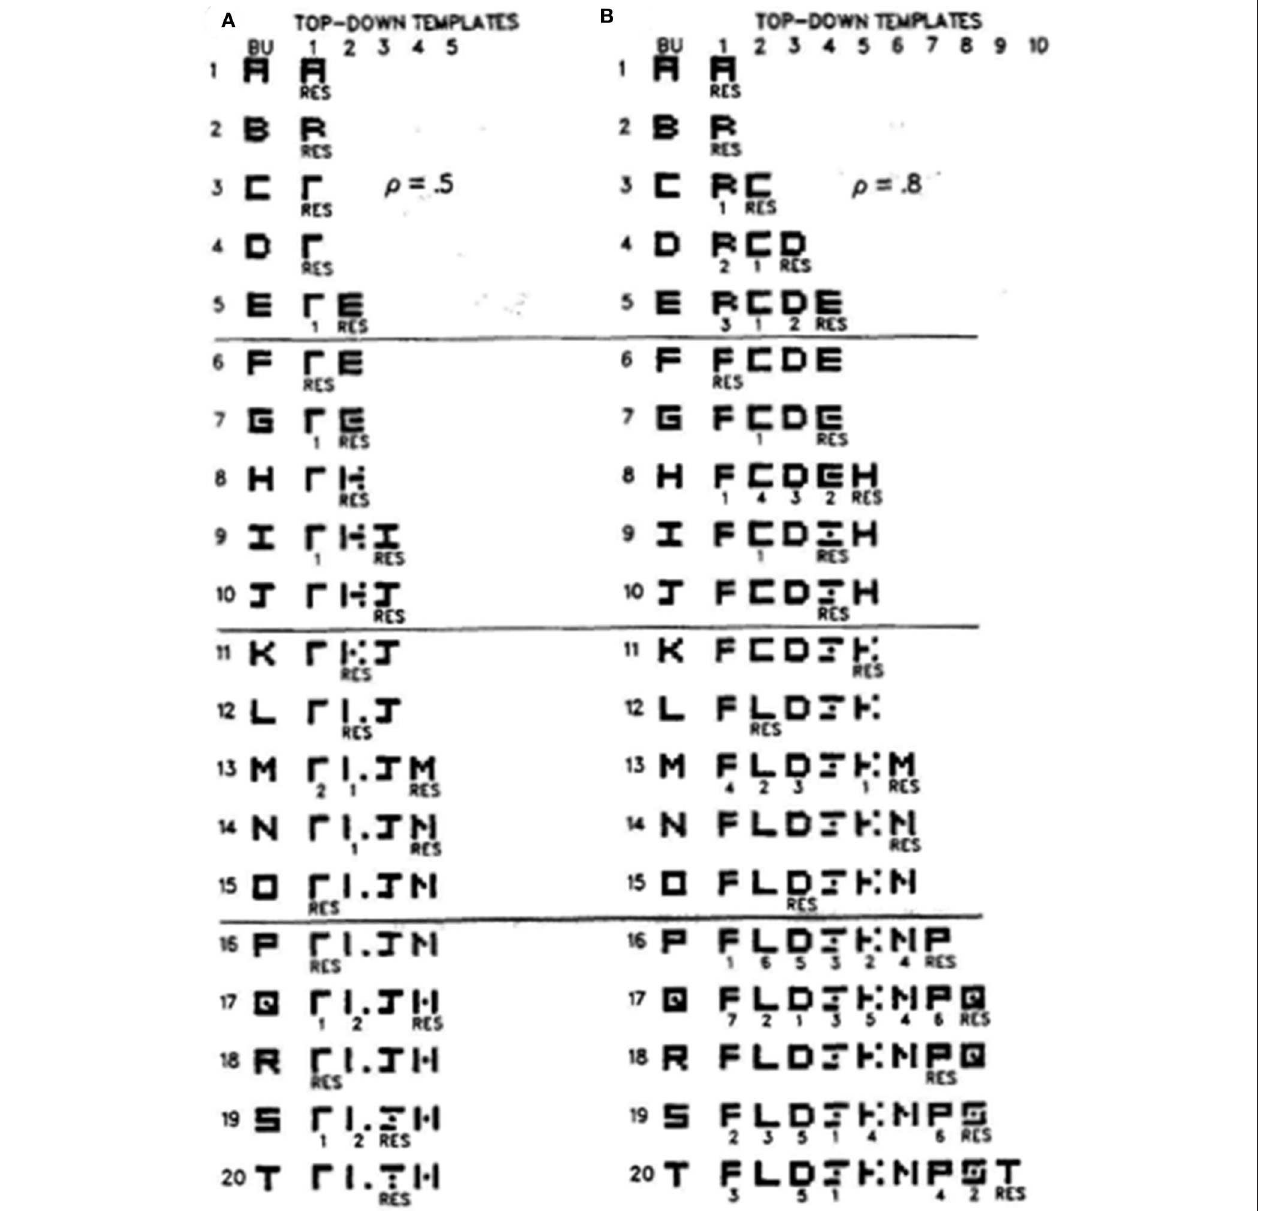
FIGURE 7 | These computer simulations show how the alphabet A, B, C, … is learned by the ART 1 when vigilance is chosen to equal (A) 0.5, or (B) 0.8. Note that more categories are learned in (B) and that their learned prototypes more closely represent the letters that they categorize. Thus, higher vigilance leads to the learning of more concrete categories. See the text for details [reprinted with permission from Carpenter and Grossberg